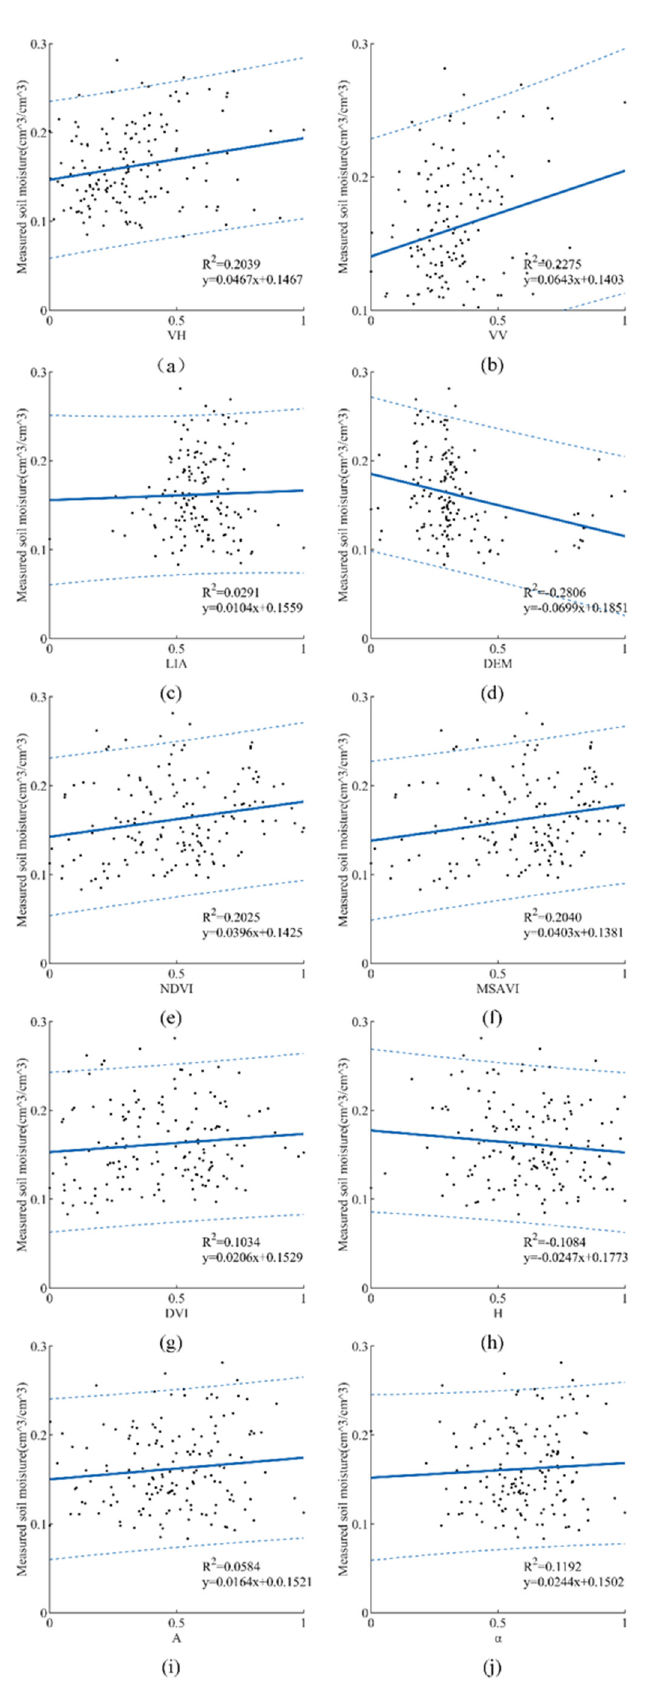
Figure 5. Correlation analysis between input parameters and SMC.